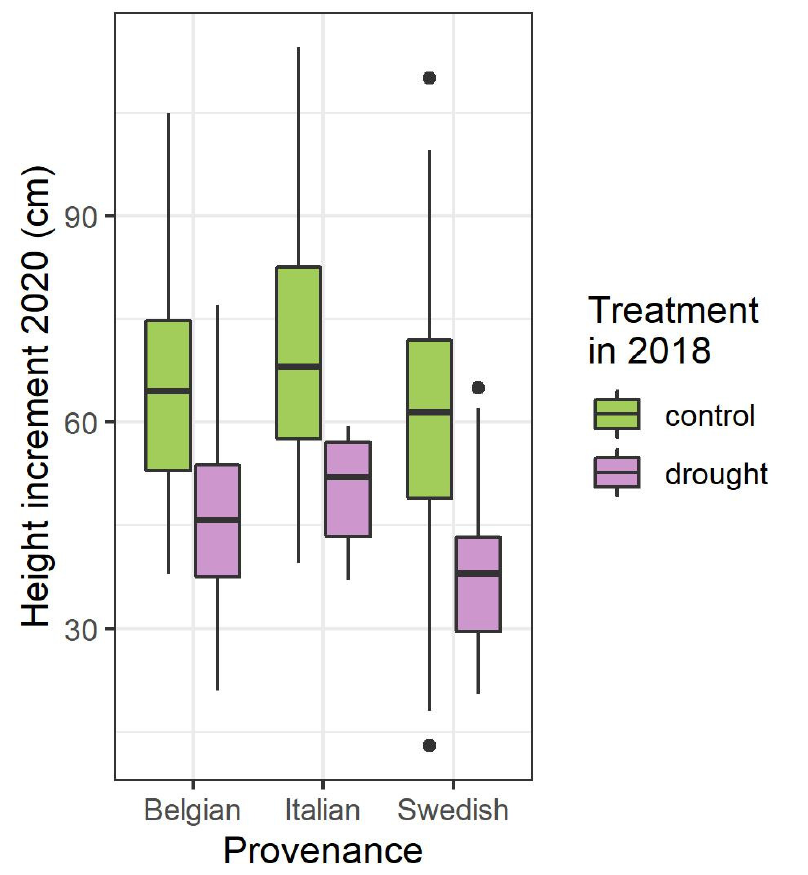
Figure 1. Boxplot representing the height increment of the shrubs in the common garden in 2020, according to the provenances and treatment in 2018.